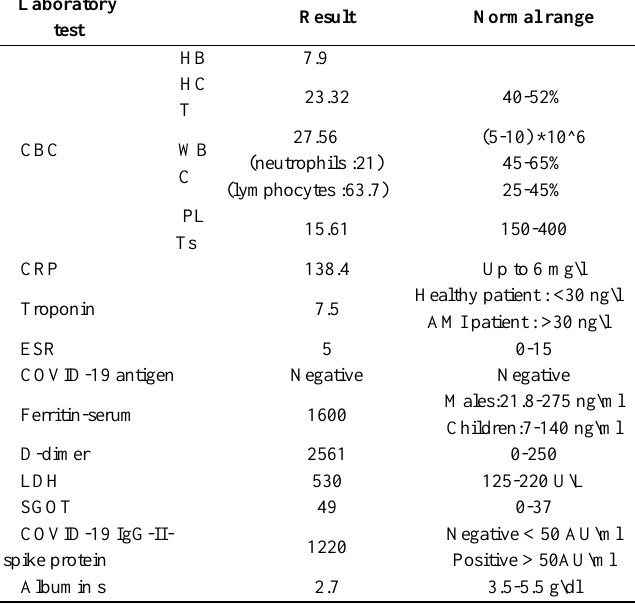
Table 1: Lab values after starting